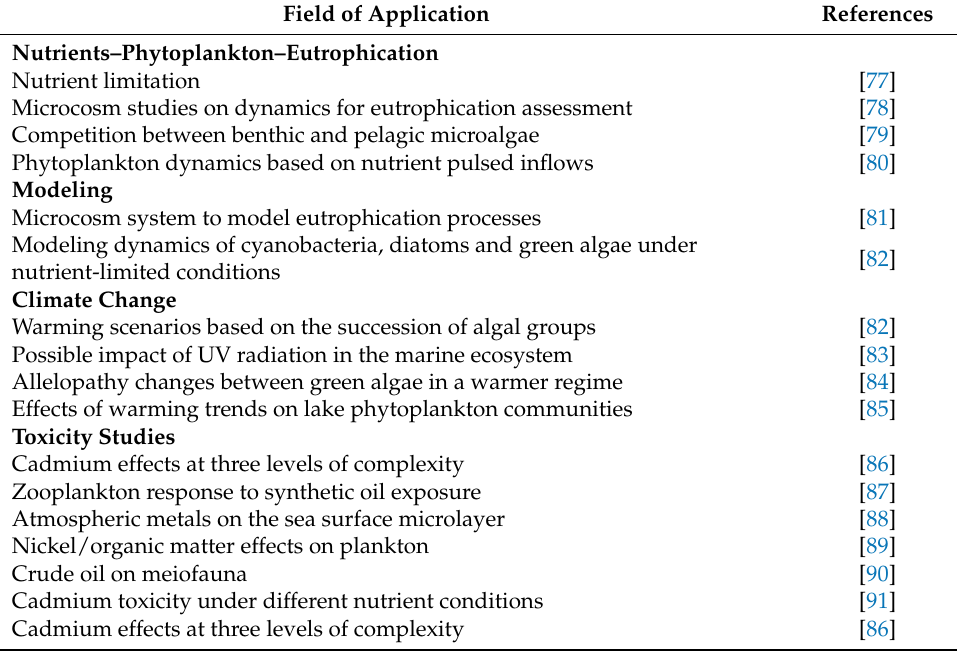
Table 3. The main fields of application of aquatic microcosm